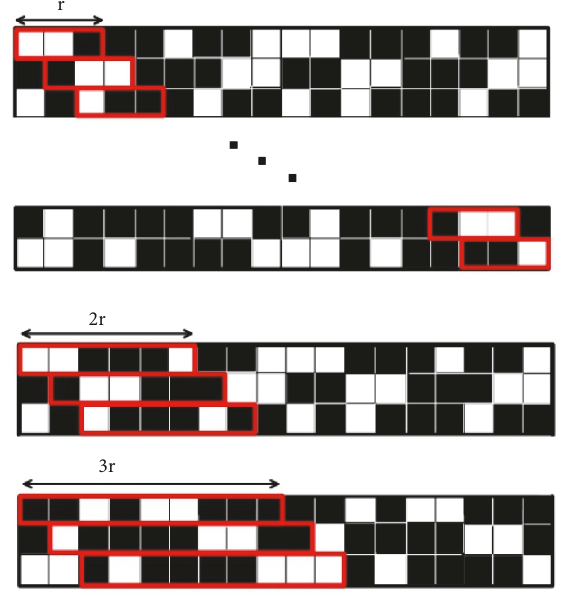
Figure 6: The gliding box principal for calculating Lacunarity.